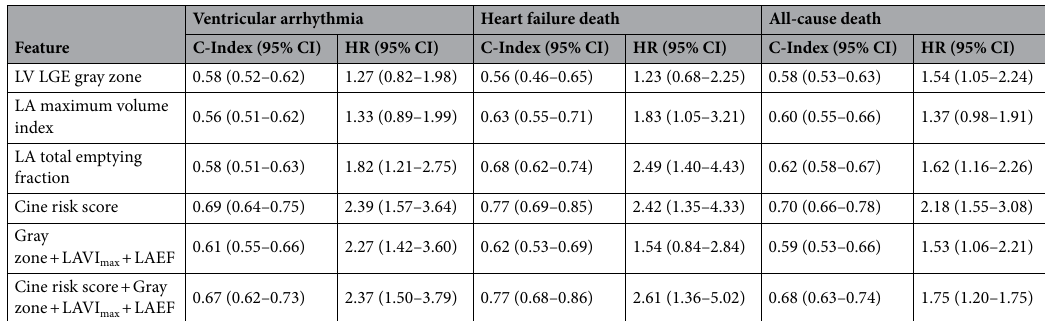
Table 4. Univariate Cox hazards model of cine risk scores calculated by the risk predictor autoencoder network. CI confidence interval, HR hazard ratio, LV left ventricular, LGE late gadolinium enhancement, LA left